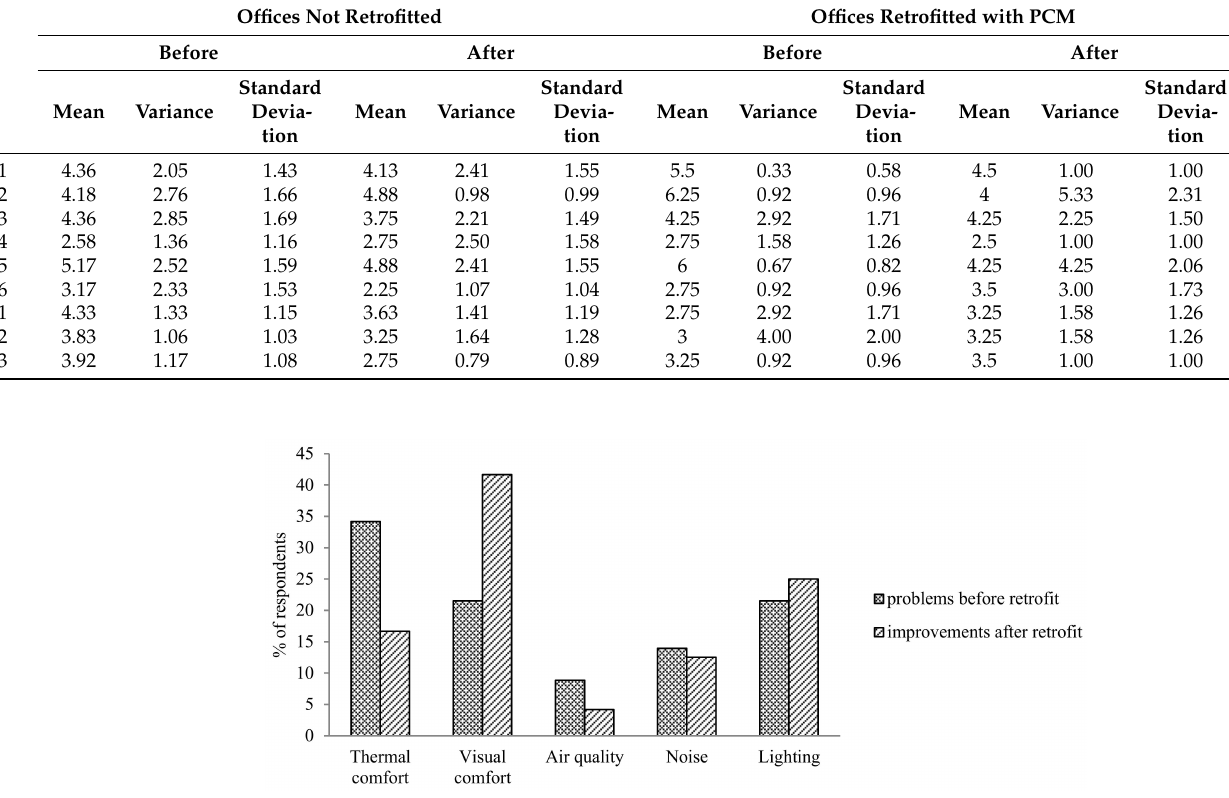
Figure 4. Improvement of indoor environmental parameters in Richard Crossman.